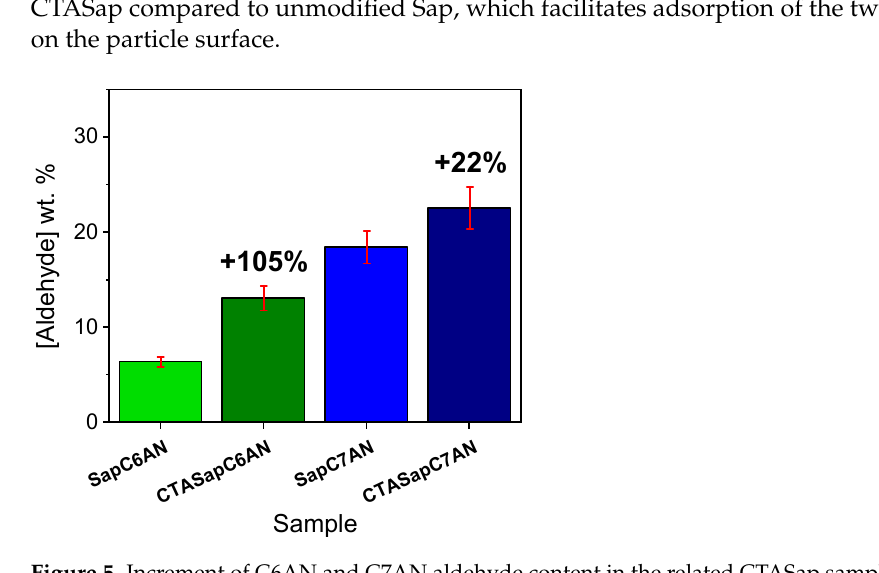
Figure 5. Increment of C6AN and C7AN aldehyde content in the related CTASap samples, compared to the parent solids. Aldehyde content was measured by CHN analysis.